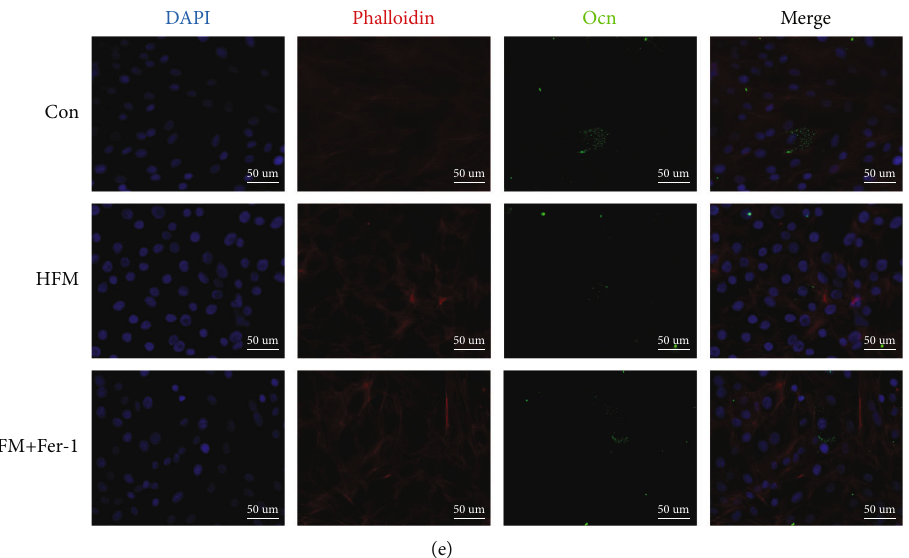
Figure 5: To verify that osteogenic formation is a ff ected to some extent in a high-fat environment. We treated Mc3t3-E1 cells in high-fat medium and then replaced the osteogenic induction medium for seven days of osteogenic di ff erentiation culture. We found that the level of alkaline phosphatase ALP was signi fi cantly reduced in high-fat conditioned medium-treated cells at day seven of osteogenic induction culture (a, b) and that this process could be alleviated by ferroptosis inhibitors. n = 3/group , ∗ P < 0 : 05 , ∗∗ P < 0 : 01 . Early intracellular osteogenic di ff erentiation was measured by immuno fl uorescence at day seven of osteogenic di ff erentiation in high-fat-treated cells Osterix (c), Rux2 (d), and Ocn (e) found to be reduced to varying degrees. The addition of Fer-1, a ferroptosis inhibitor, to the high-fat medium treatment signi fi cantly reduced the expression of osteogenic marker proteins (c –